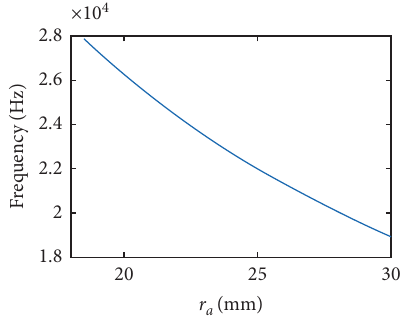
Figure 10: Relationship between natural frequency and inner